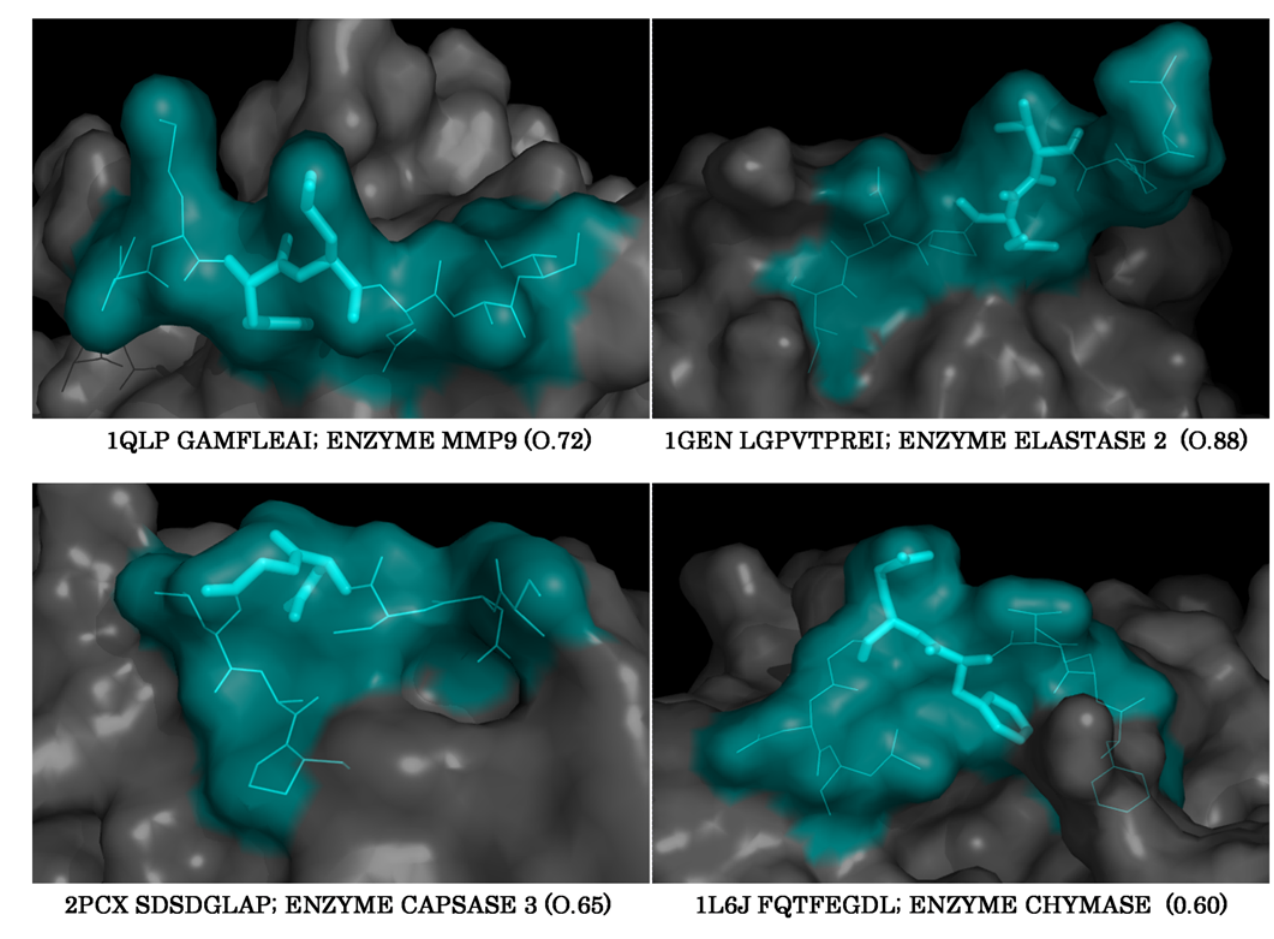
Figure 1. The three dimensional context of the cleavage sequences in natural substrates. a) Structures of the known protein substrates of proteases with their octapeptide cleavage sequences are depicted in cyan. Amino acids at the P1 and P1 9 positions are represented as sticks. Protein structure is represented as a surface. The rSASA values for the P3P2P1P1 9 sequence is shown in parenthesis.